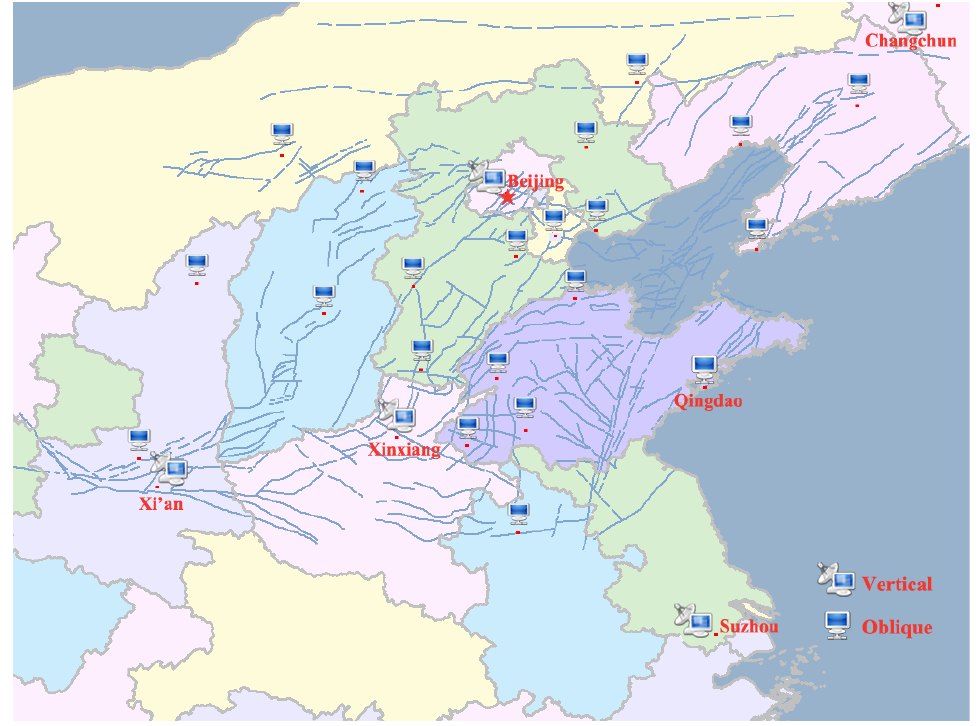
Fig. 6. The distribution of the ground-based high-resolution ionospheric observation (GBHIO) network. the epicenter. There was no obvious negative perturbation on the opposite side, which may be due to sparse ionospheric vertical sounding stations in the West of the epicentre, and inadequate data of fo F2 parameter that can be analysed (Xu et al.,